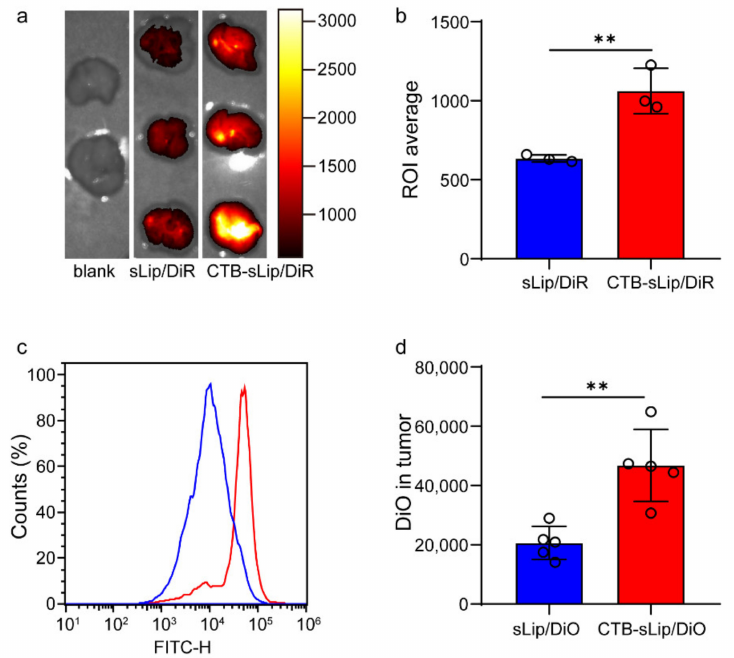
Figure 8. Targeting capability of CTB-sLip to lung metastasis of colorectal cancer in vivo. Male BALB/c nude mice planted with HT-29 cells in left lungs were injected with CTB-sLip/DiR (( a , b ), n = 3) for in situ imaging and CTB-sLip/DiO (( c , d ), n = 5) for cellular uptake study; sLip/DiR and sLip/DiO were set as the controls. Data are means ± SDs. ** p < 0.01 based on Student’s t